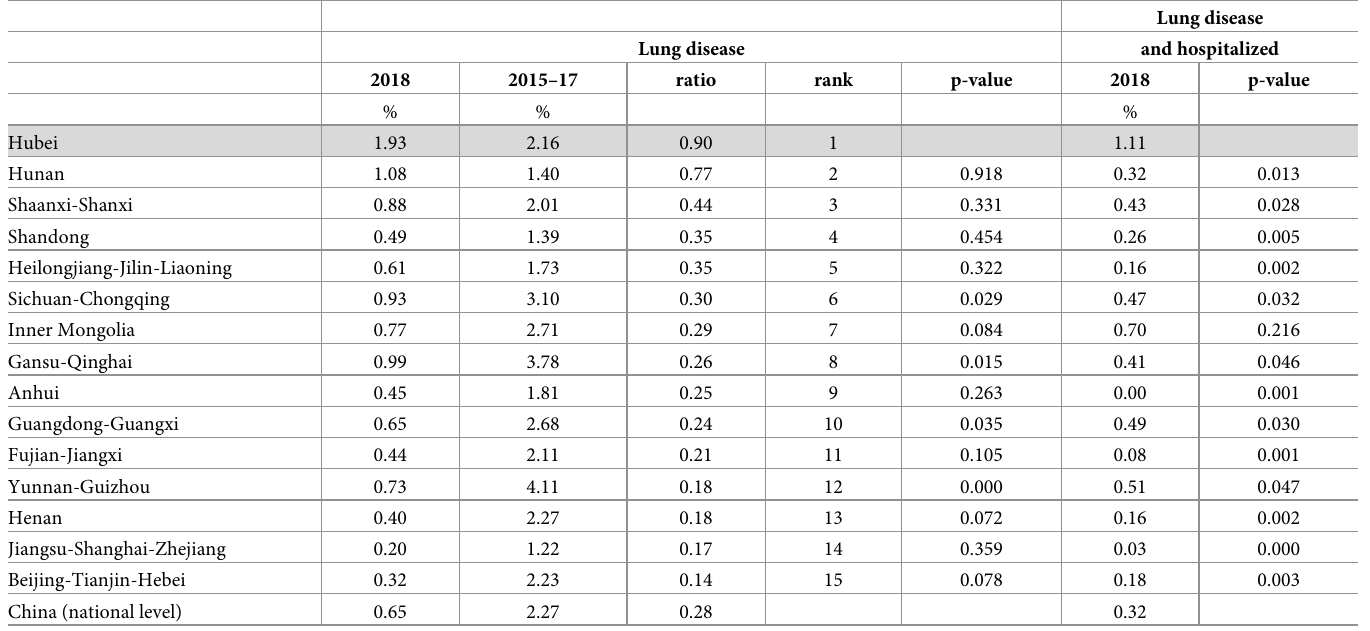
Table 3. Diagnosis of lung disease by year